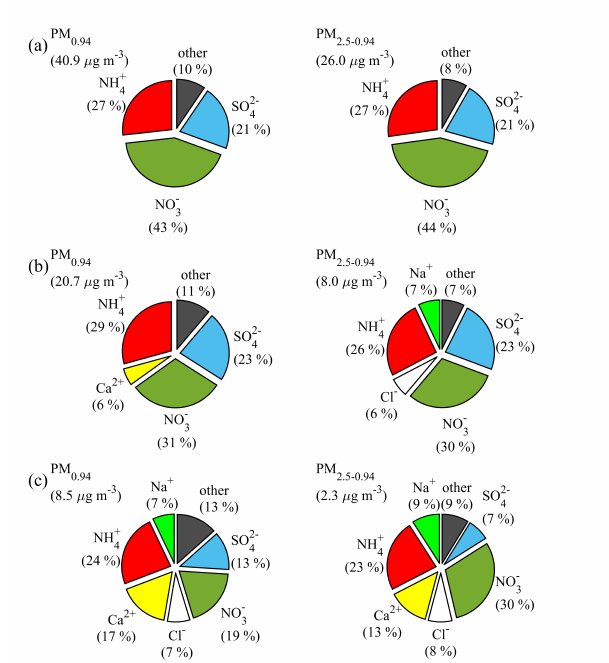
Figure 6. Percent composition of (left panels) PM 0 . 94 and (right panels) particulate mass between 0.94 and 2.50µm (PM 2 . 5 − 0 . 94 ) for the (a) polluted, (b) transition, and (c) clean periods. Any pa- rameter with percent mass composition ≤ 5% is grouped into the “other” category of each diagram. Mean mass concentrations as- sociated with PM 0 . 94 and PM 2 . 5 − 0 . 94 for the three time periods (weighted by sample duration for each period) are provided next to each